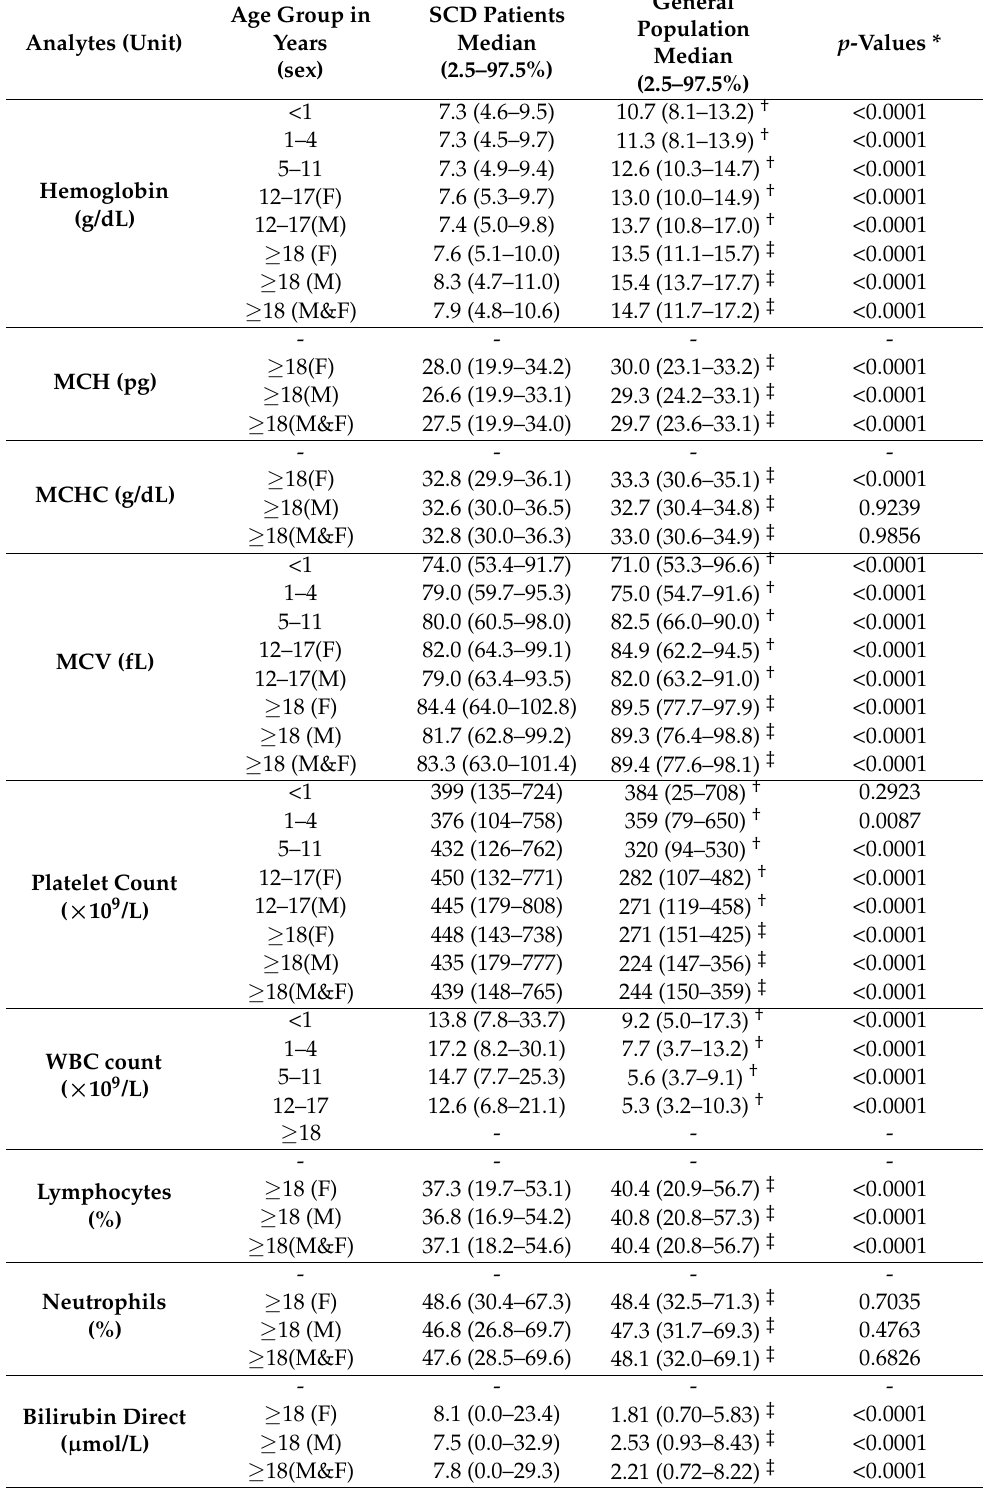
Table A1. Medians (95% reference ranges) in selected laboratory parameters for SCD at steady states compared to published population data in